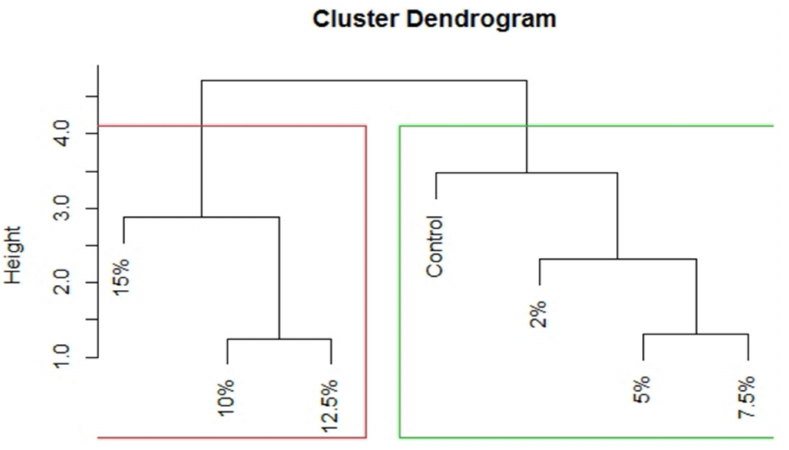
Figure 4. Unweighted pair group method with arithmetic mean (UPGMA) depicting the grouping based on all the nutritional composition parameters.